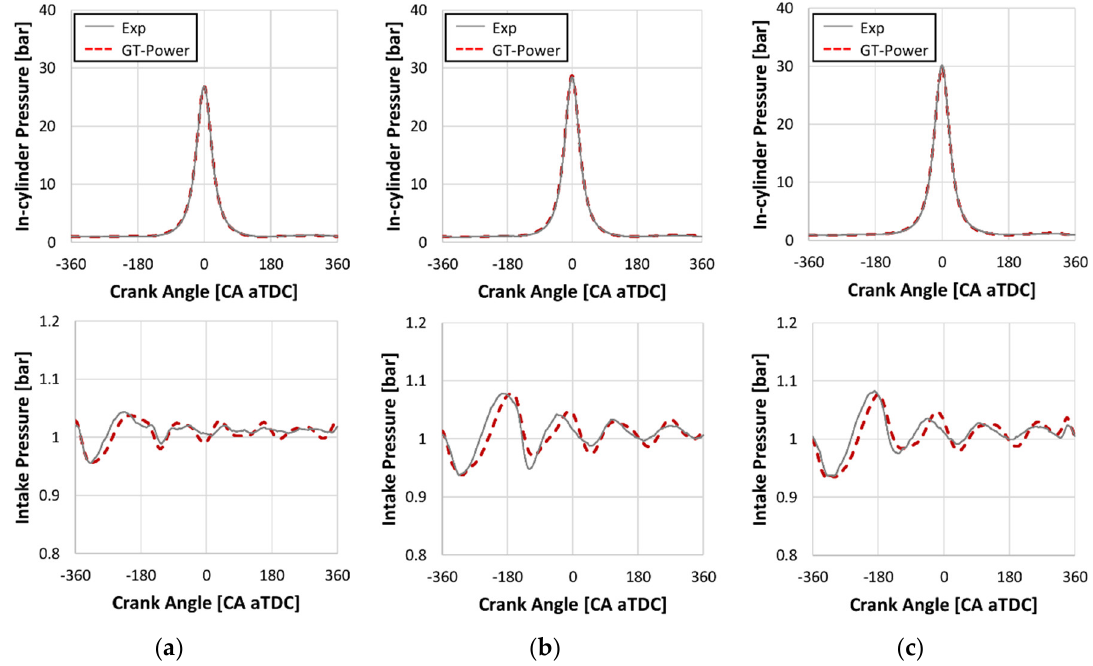
Figure 9. One-dimensional (1D) simulation results in motoring conditions: ( a ) 1500 rpm, WOT, INCam 30 CA advanced; ( b ) 2000 rpm, WOT, INCam 30 CA advanced; ( c ) 2000 rpm, WOT, INCam fully retarded.